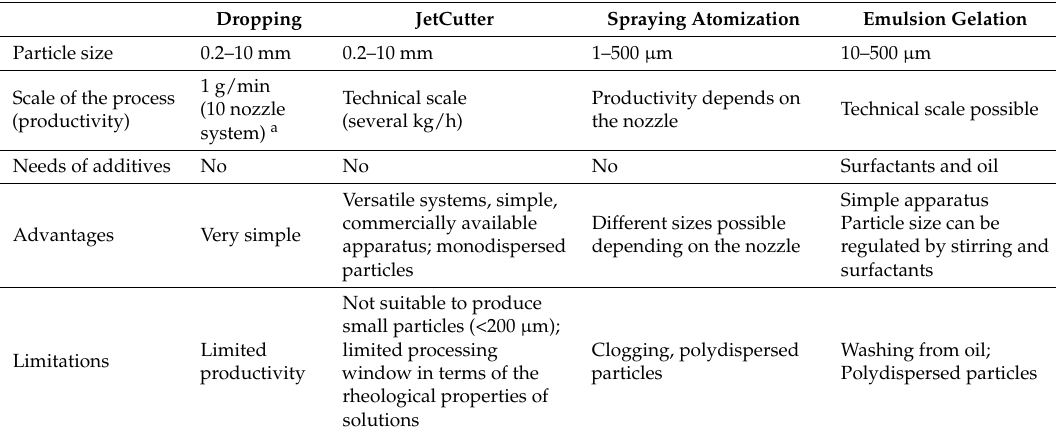
Table 3. An overview of the processes applicable for production of polysaccharide gel particles (after drying, aerogels can be